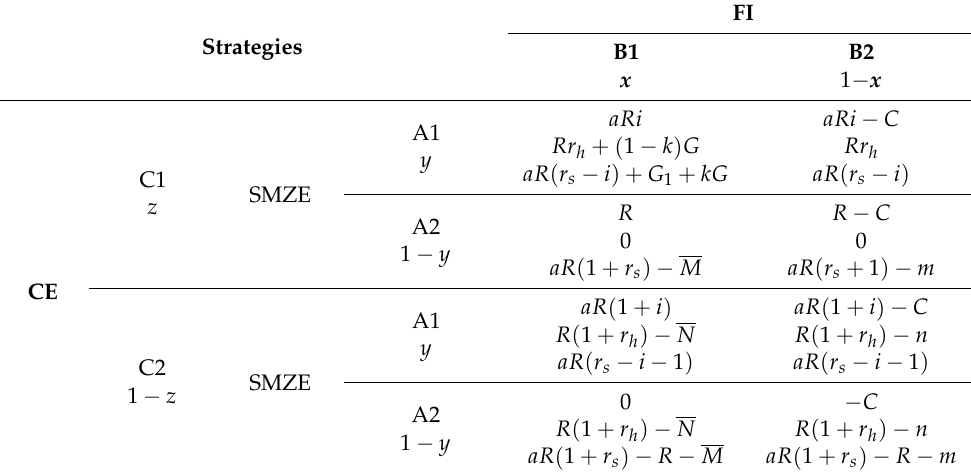
Table 2. The profit matrix of the tripartite